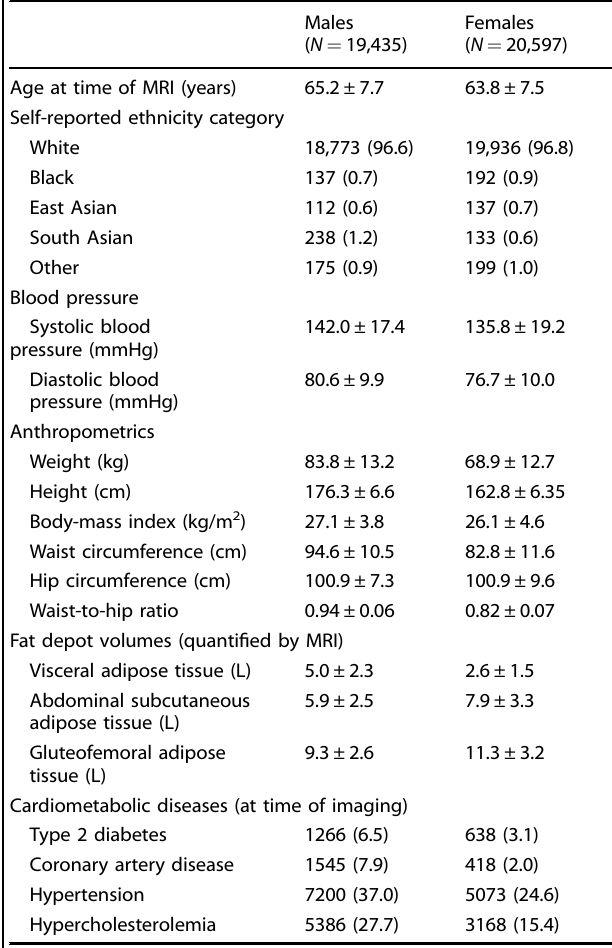
Table 1. Characteristics of the study